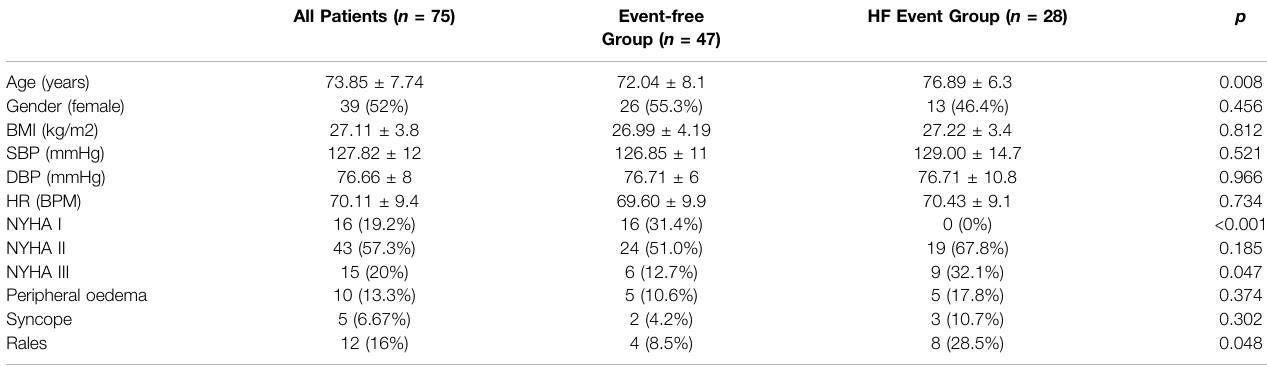
TABLE 1 | Clinical characteristics of the study population and comparisons between patients with and without events. All Patients ( n =